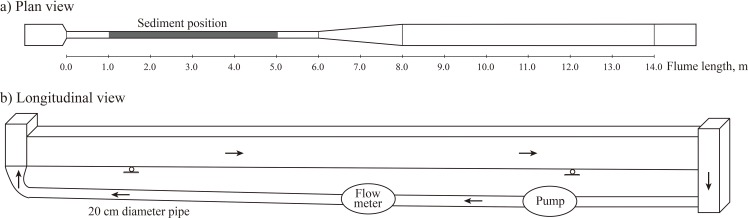
(a) Top view and (b) longitudinal view of the recirculating flume, including an upstream channel (0 m < x < 6 m), an expansion region (6 m < x < 8 m) and a downstream channel (8 m < x < 14 m).The sediment is shown by the gray bar from 1 m to 5 m.